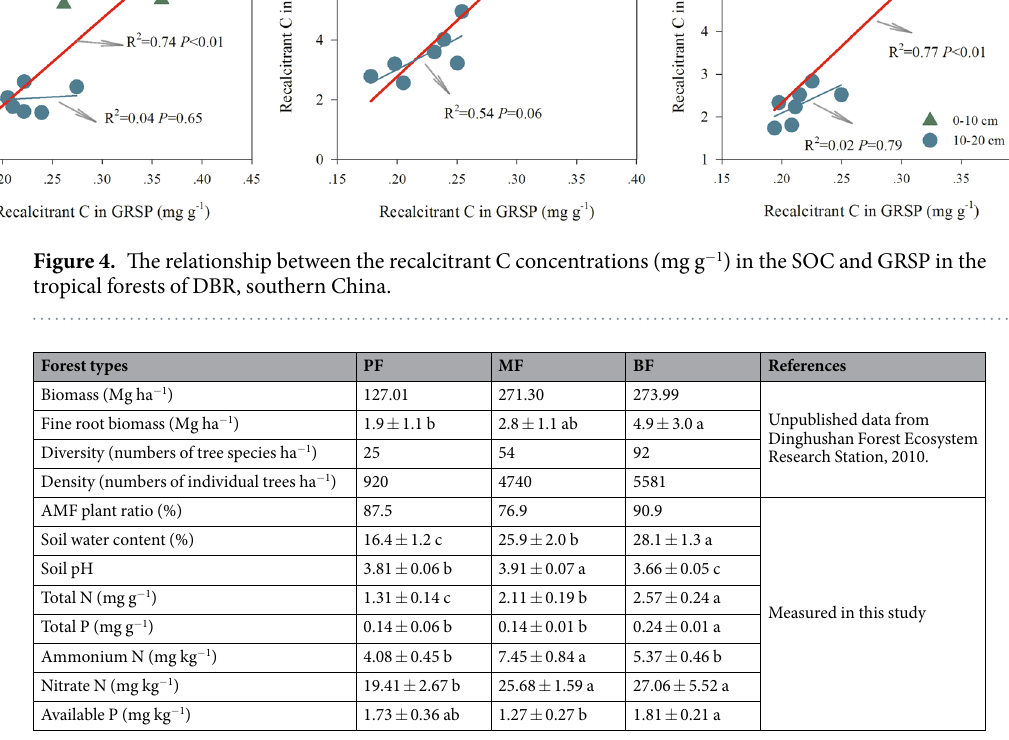
Table 2. Characteristics of tropical forests and soils (0–10 cm soil) in the DBR, southern China. Mean values with standard deviations derived from 7 replications are presented in fine root biomass and soil parameters. Different lowercase letters indicate significant differences among the forests ( P <